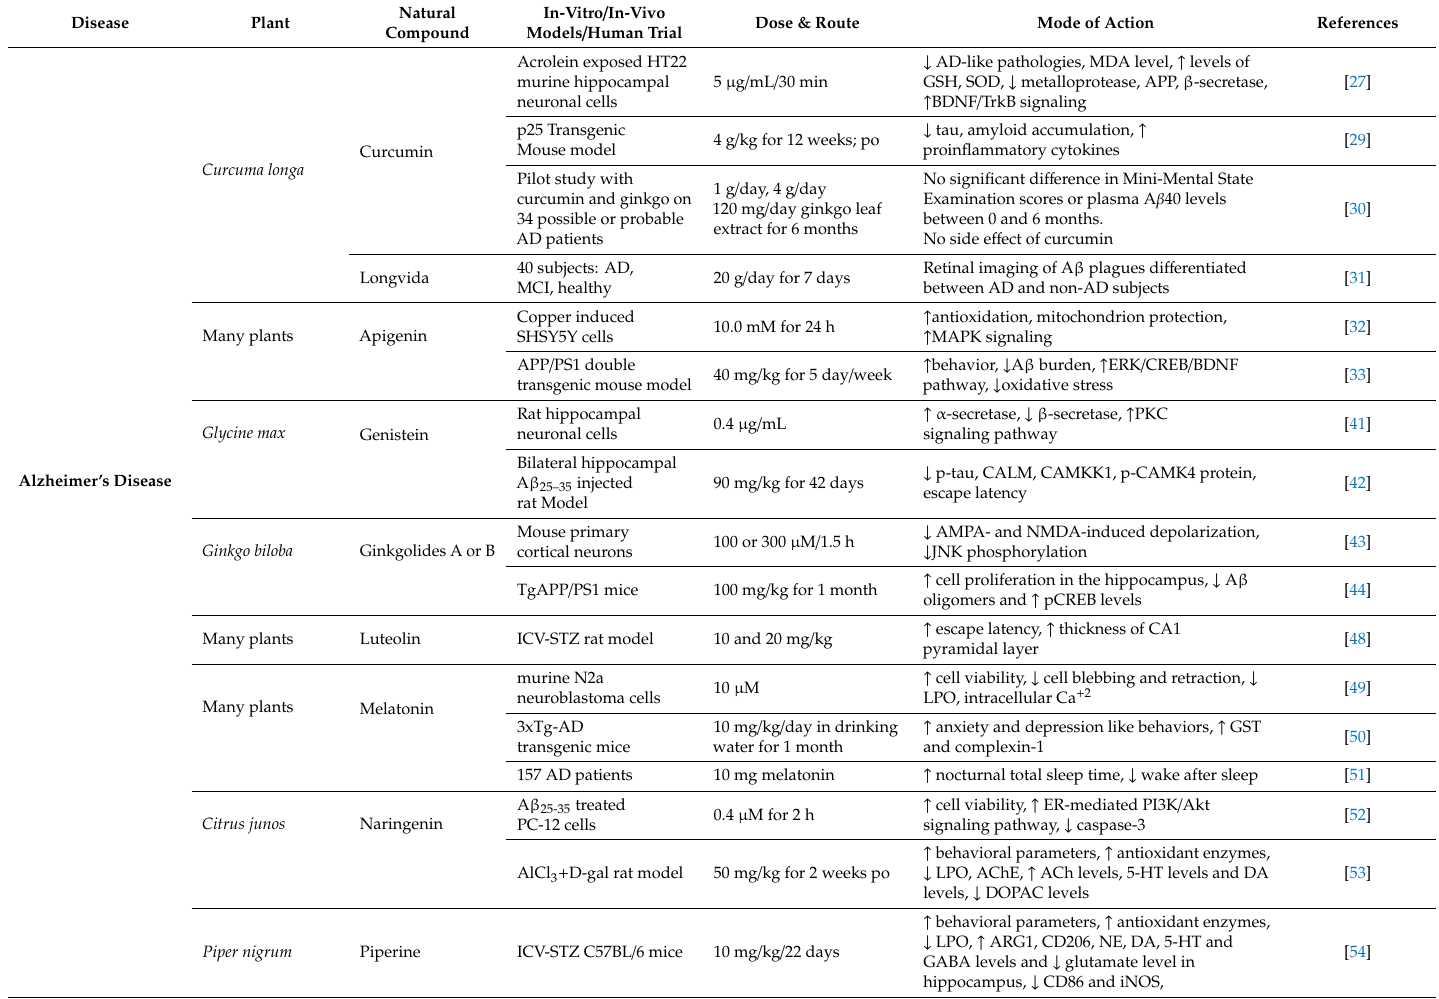
Table 1. Role of various phytochemicals in di ff erent neurodegenerative diseases with possible mechanisms of action with special reference to in vitro, in vivo and clinical